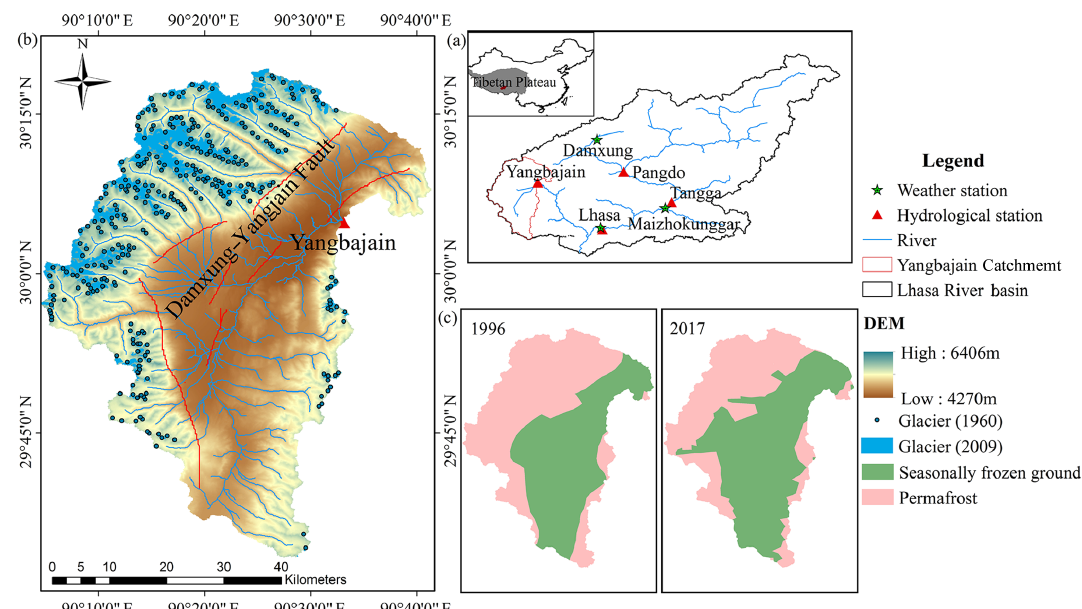
Figure 1. (a) The location, (b) elevation and glacier distribution from the Second Chinese Glacier Inventory, as only the location of glacier snouts in 1960 were provided in the First Chinese Glacier Inventory, whereas the boundaries of glaciers were shown in the Second Chinese Glacier Inventory. (c) Second Chinese Glacier Inventory maps of frozen ground distribution (Li and Cheng, 1996; Zou et al., 2017) in the Yangbajain Catchment.